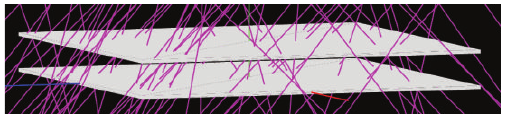
Figure 4: The schematically view of the muons interacting with the new detection system, observed with GEANT 4.94 code (magenta lines represent muons). We can see that not all muons that cross the first scintillator layer will pass through the second